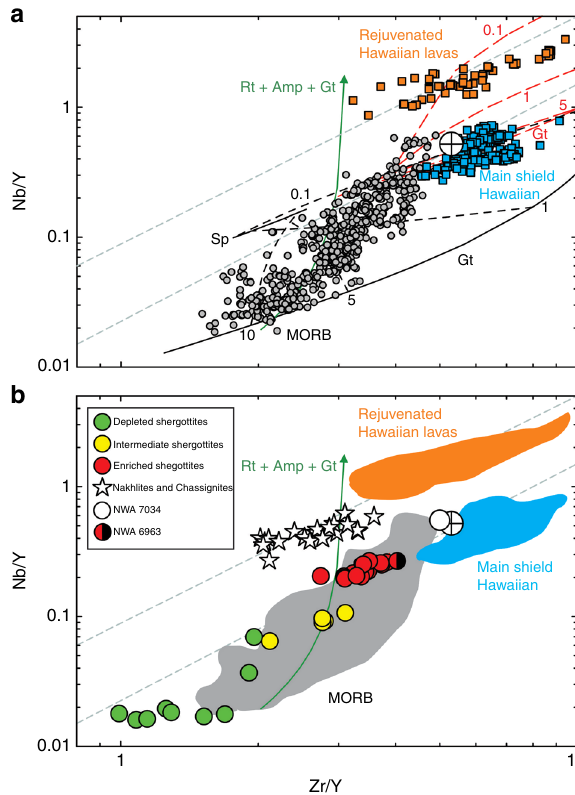
Fig. 4 Double-normalized (to CI-chondrite and Sm) incompatible trace-element plots for martian shergottites, and nakhlites and chassignites. Shergottites are shown in a and nakhlites and chassignites are shown in b . Shergottite NWA 6963 is highlighted due to its similarity in incompatible element composition to nakhlites. Normalization to CI-chondrite from ref. 39 . Analytical uncertainties are smaller than symbols